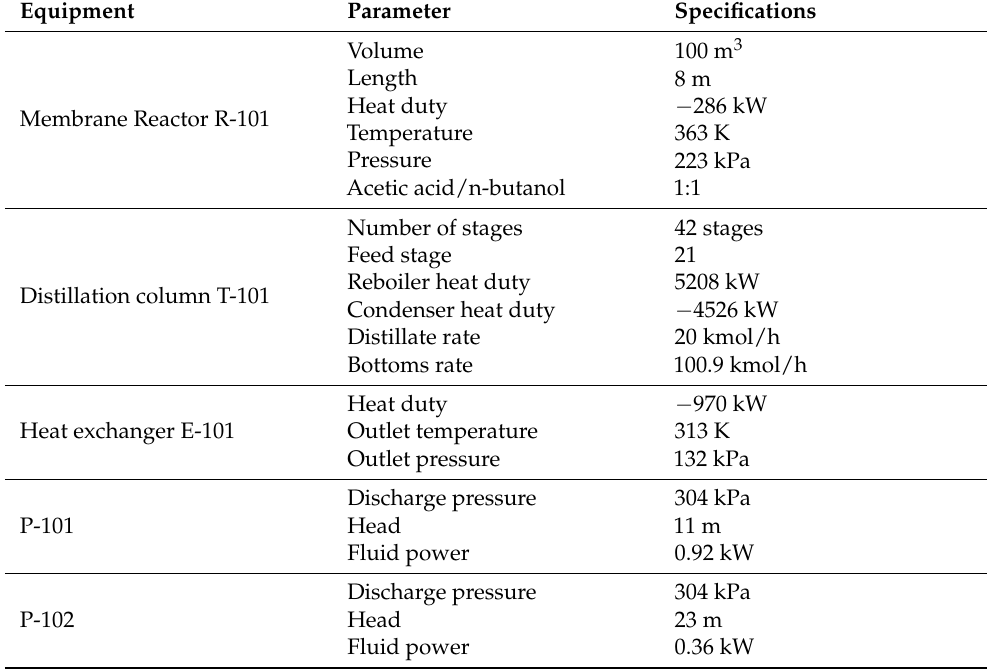
Table 5. Major equipment parameters summary for the MR-based